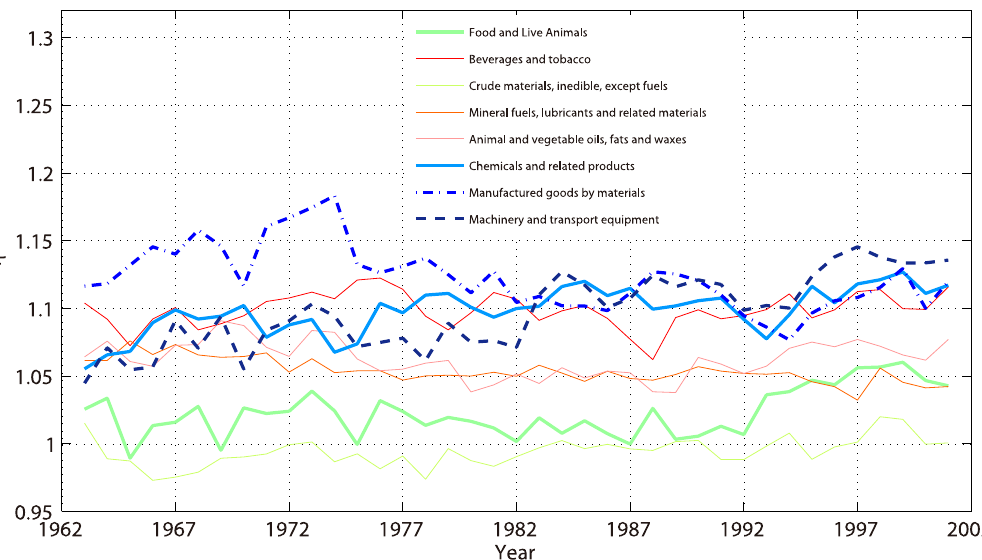
Figure 7. Allometric exponents g s of 1-digit classification products change with time.